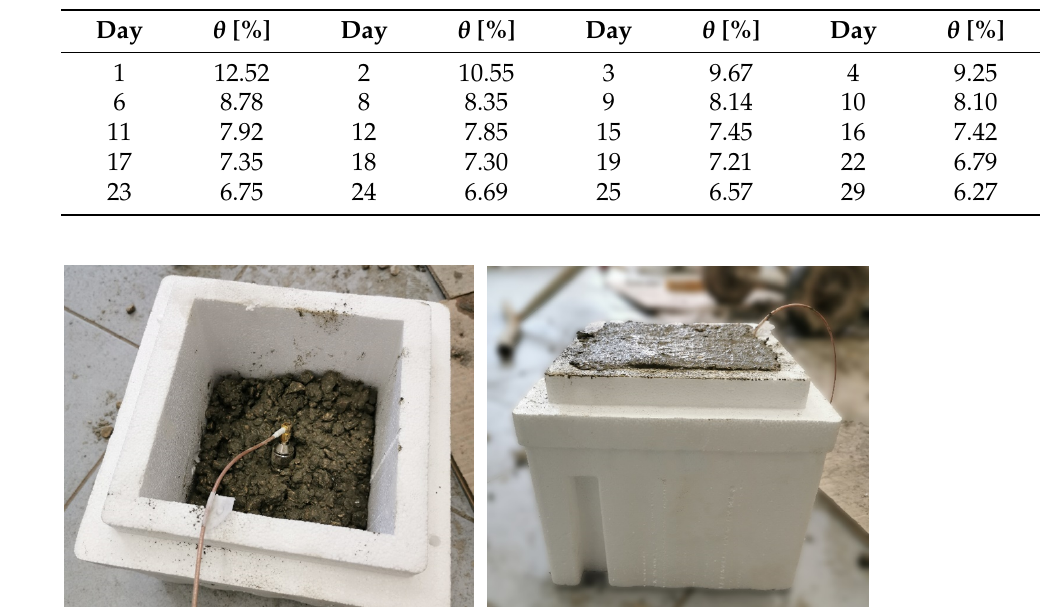
Table 1. Volumetric water content percentage in the concrete specimen throughout the observation period.